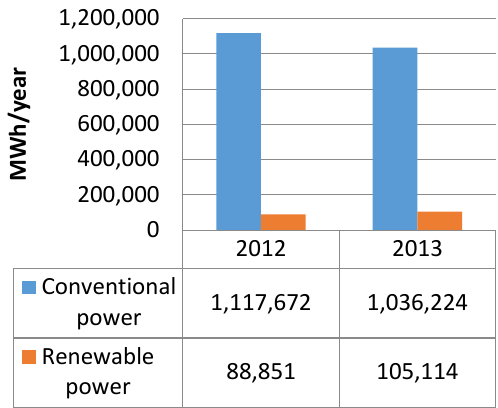
Figure 8. Participation rates of conventional and renewable power plants in energy production in 2012 and 2013 [51].